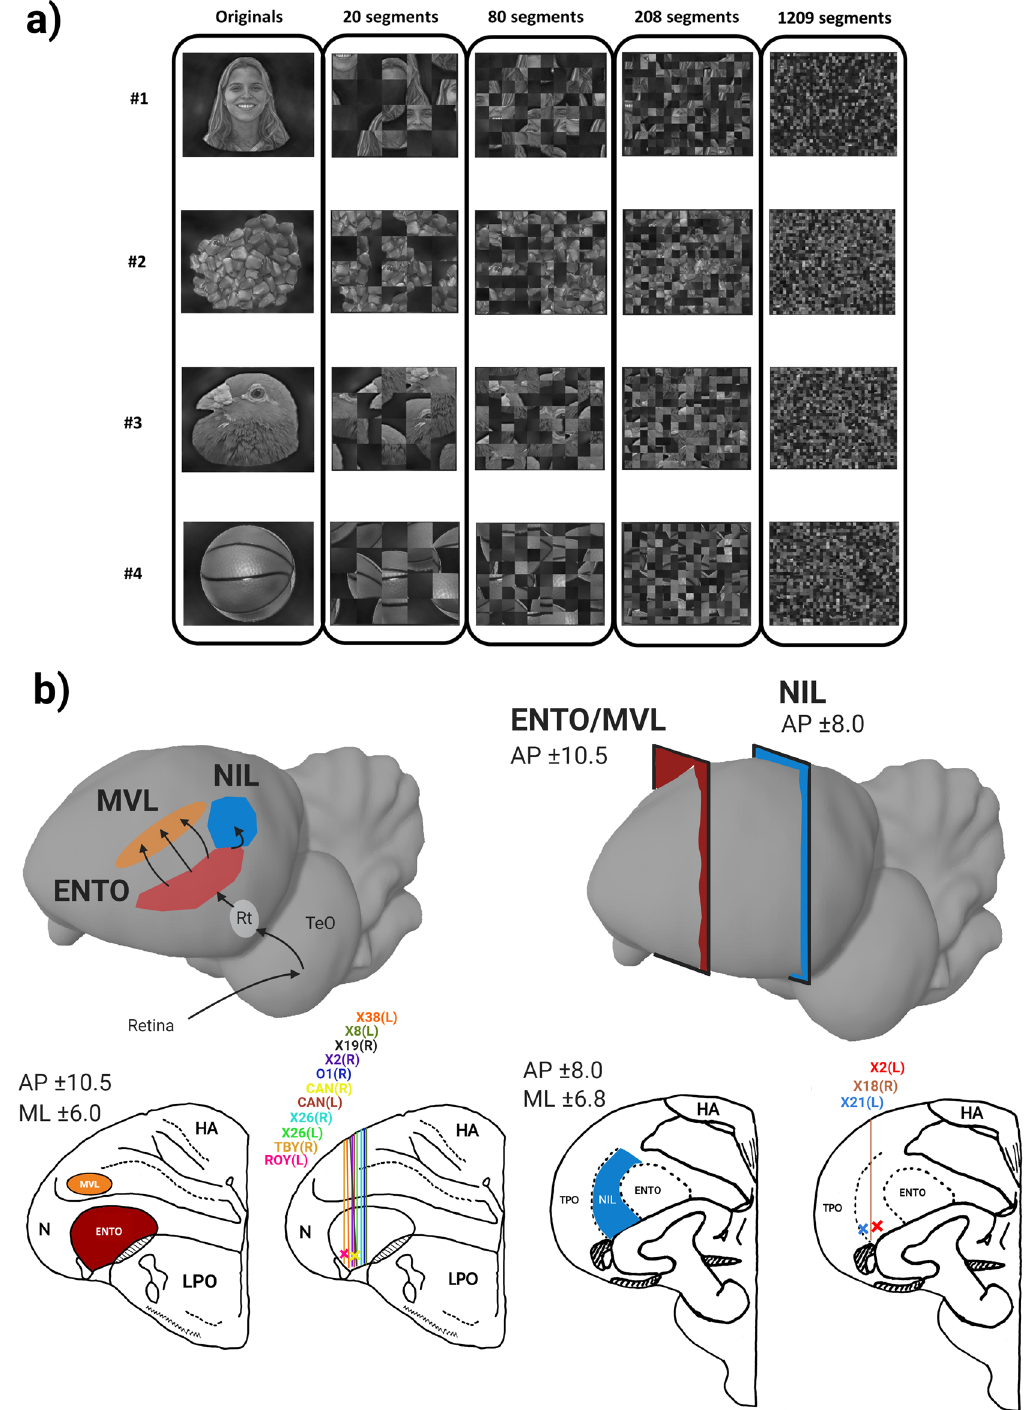
Figure 1. ( a ) Stimulus set used for the experiment. Images of four different objects (originals) and four corresponding levels of progressive image scrambling (20, 80, 208, and 1209 segments). ( b ) Targeted MVL (orange), ENTO (red), and NIL (blue) regions. Also depicted is the electrode track reconstruction for all pigeons at the corresponding AP ± 10.5 and ± 8.0 coronal brain sections. Abbreviations 16 : nidopallium (N), nidopallium intermediate pars lateralis (NIL), mesopallium ventrolaterale (MVL), hyperpallium apiciale (HA), lobus parolfactorius (LPO), area temporo-parieto-occipitalis